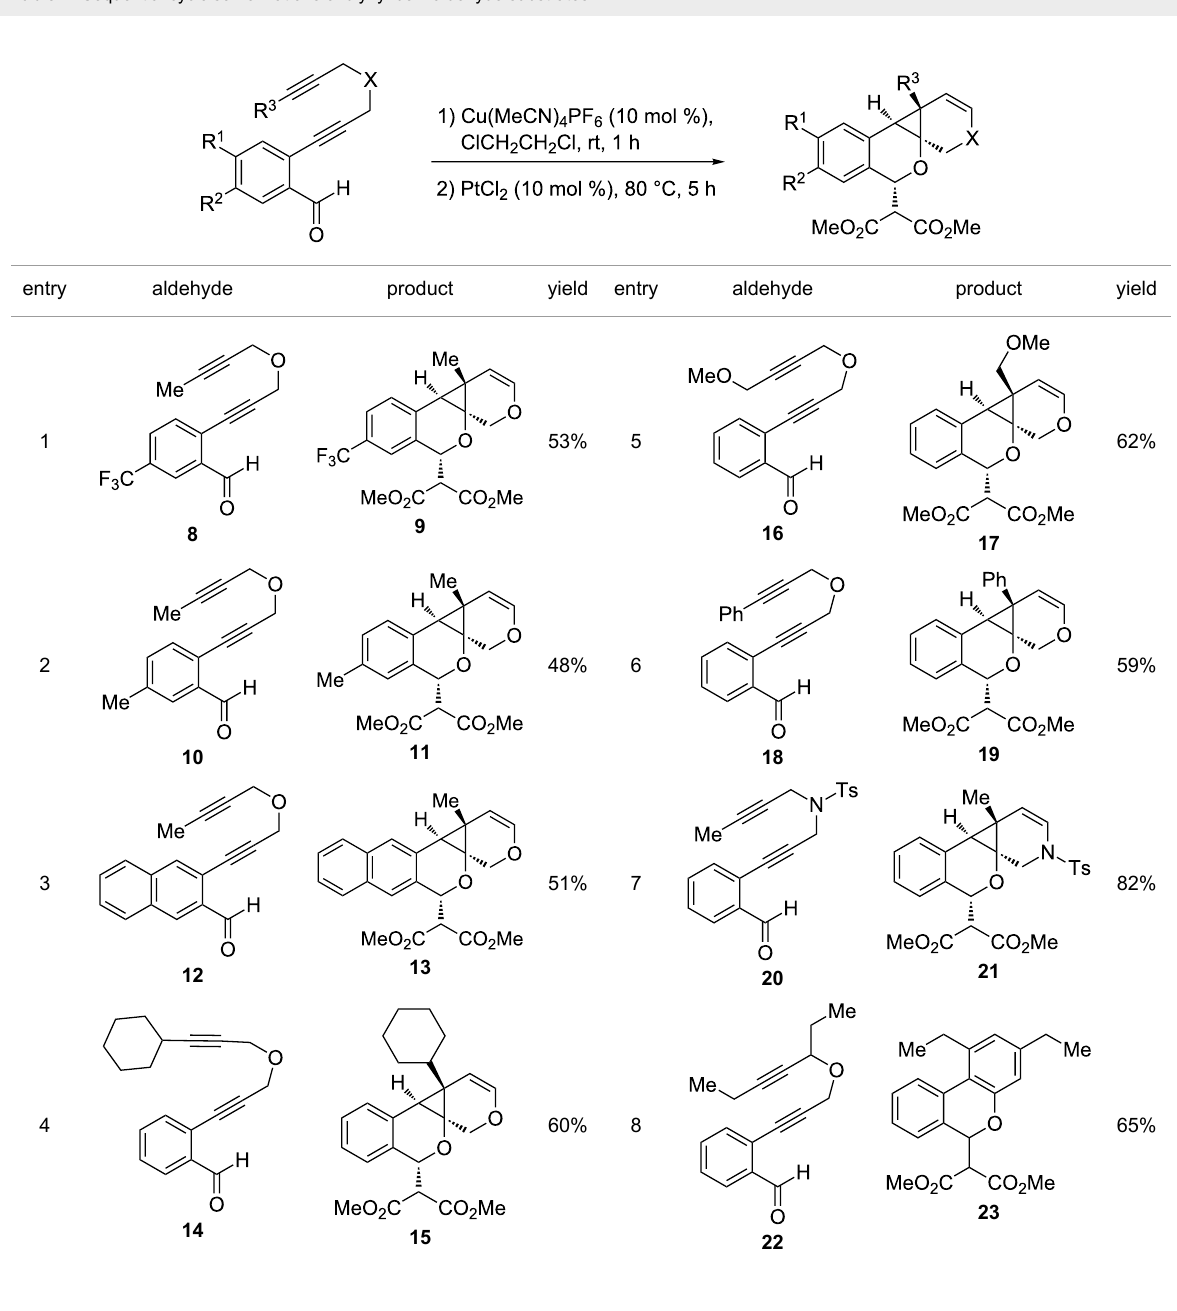
Table 1: Sequential cycloisomerizations of diynyl benzaldehyde